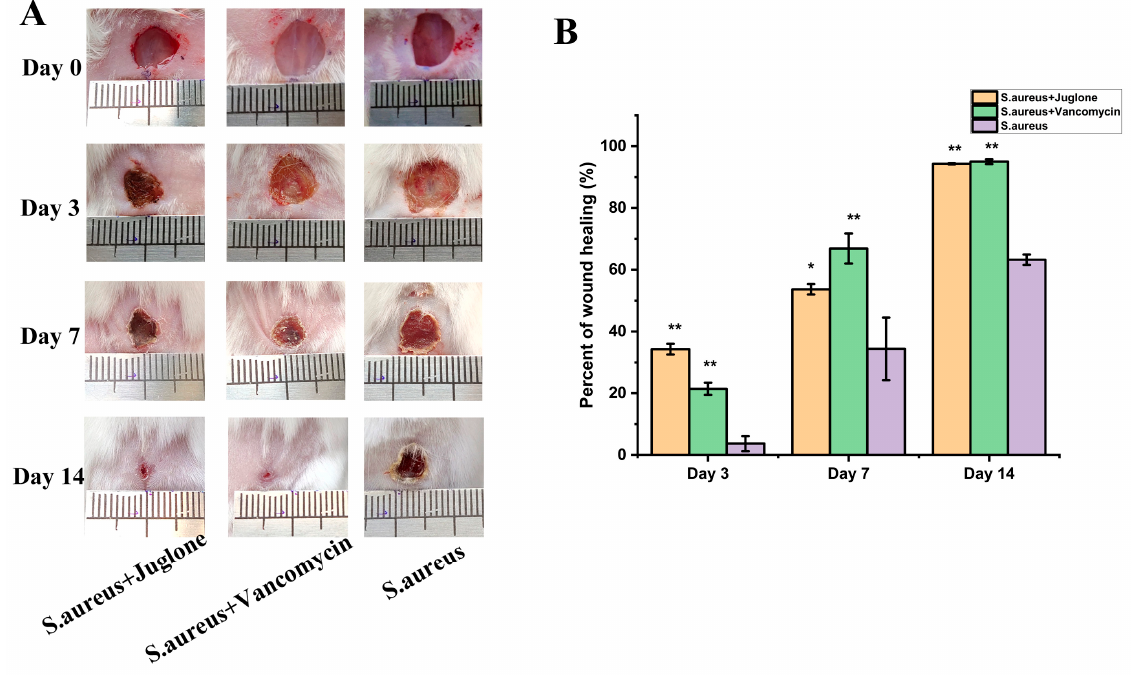
Figure 8. Effect of juglone on wound healing in S. aureus infection. ( A ) Representative pictures of S. aureus infected wounds on days 3, 7 and 14 of topical treatment with juglone; ( B ) Image J calculation and analysis of the relative wound healing percentage. When p < 0.01, it is represented by **, when p < 0.05, it is represented by **.